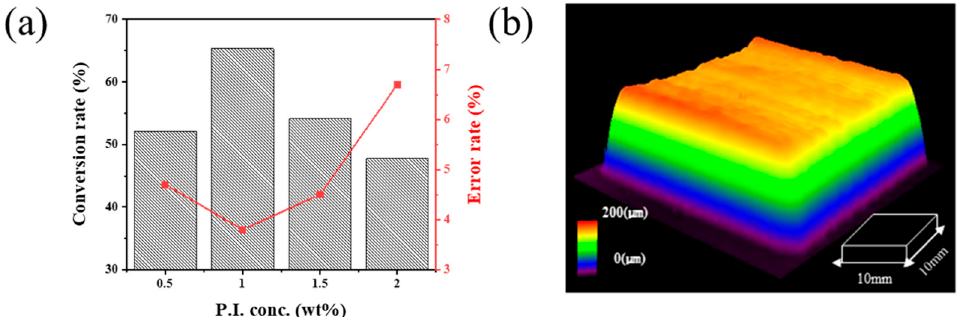
Figure 5. Ink-jet 3D printed insulation structure using photo-curable nano SiO 2 ink: ( a ) Conversion rate and error rate according to photo-initiator content and ( b ) 3D image of the insulation layer using ink-jet printed nano SiO 2 ink with 1wt% added photo-initiator.